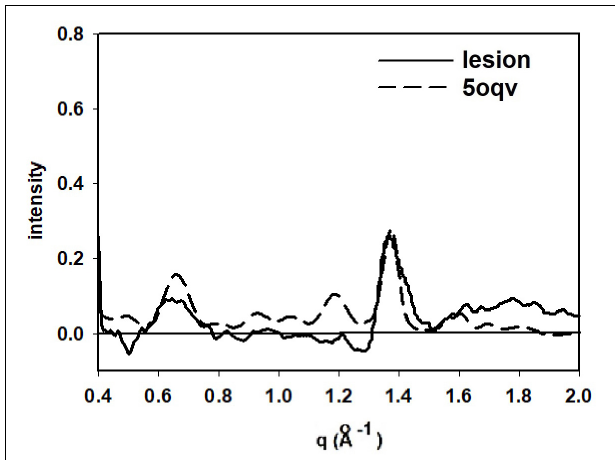
FIGURE 4 | Comparison of the scattering from lesion A (in Figure 3 ) with that predicted from the atomic coordinates in PDB file 5oqv. The patterns share prominent features at q = 0.6 Å − 1 (10 Å spacing), 1.34 Å − 1 (4.7 Å spacing) and weaker features at q ∼ 0.9 Å − 1 and 1.2 Å − 1 .strongly suggesting that the fibrils in lesion A have a structure very similar to that in the in vitro assembled Ab42 fibrils described by PDB file